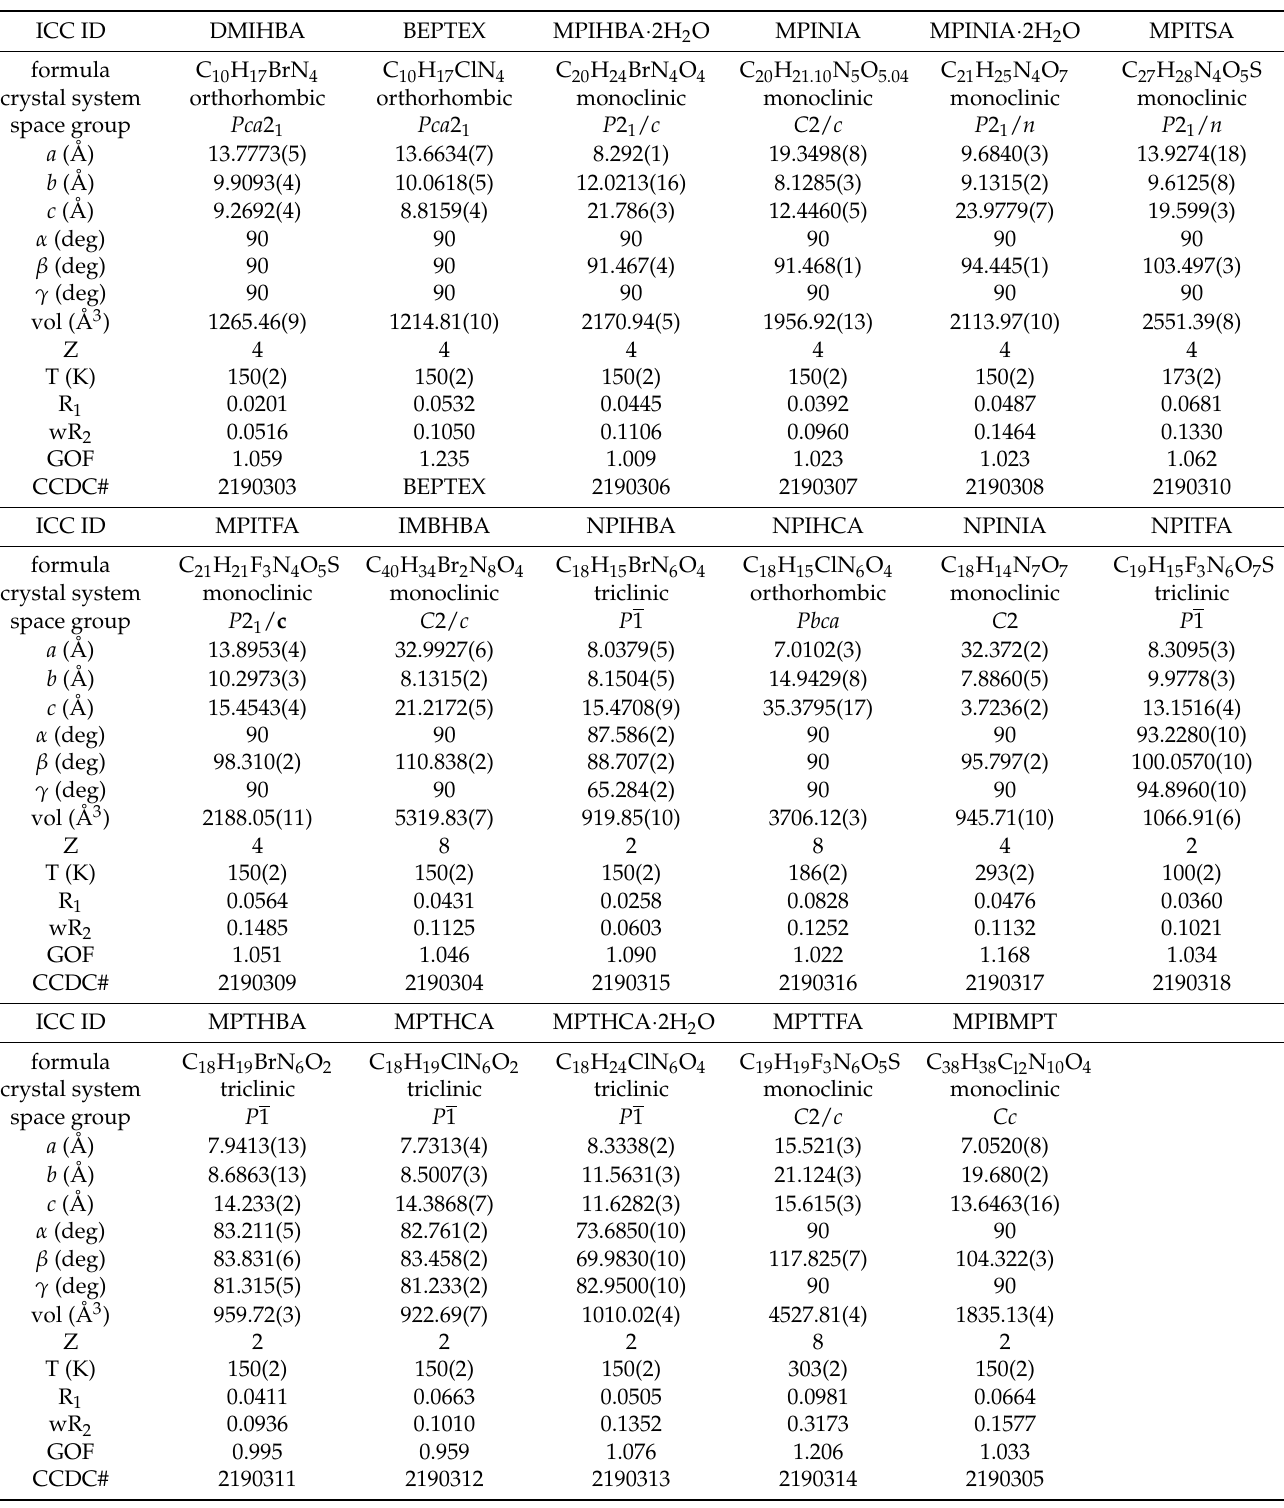
Table 1. Crystallographic data and structure refinement parameters for ICCs